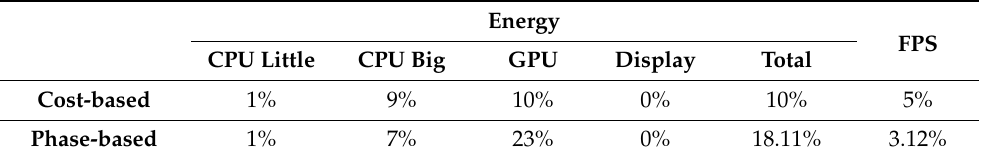
Table 7. The energy reduction rate and FPS increase rate of the cost-based low-power technique and the phase-based low-power technique for the default frequency governor. Energy FPS CPU Little CPU Big GPU Display